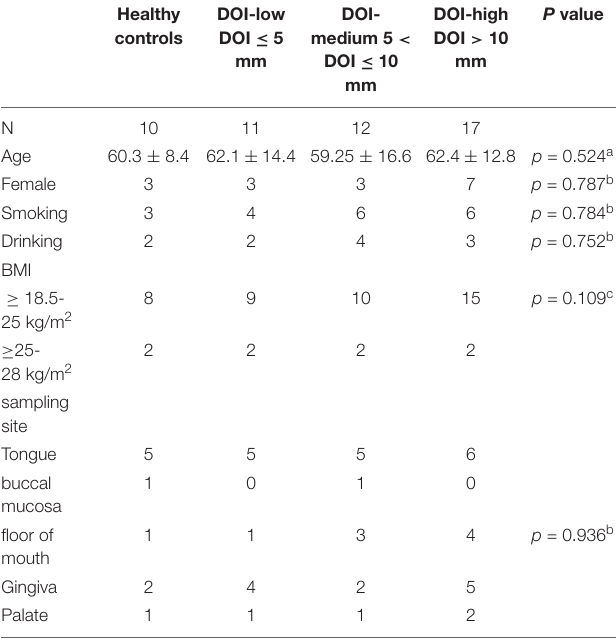
TABLE 1 | Clinical characteristics of the